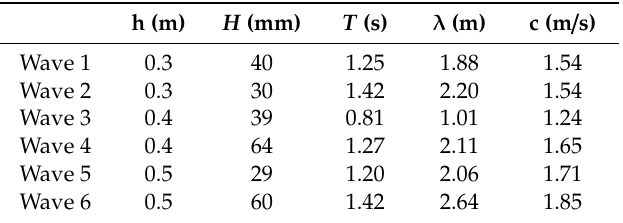
Table 1. Theoretical values of the studied waves.